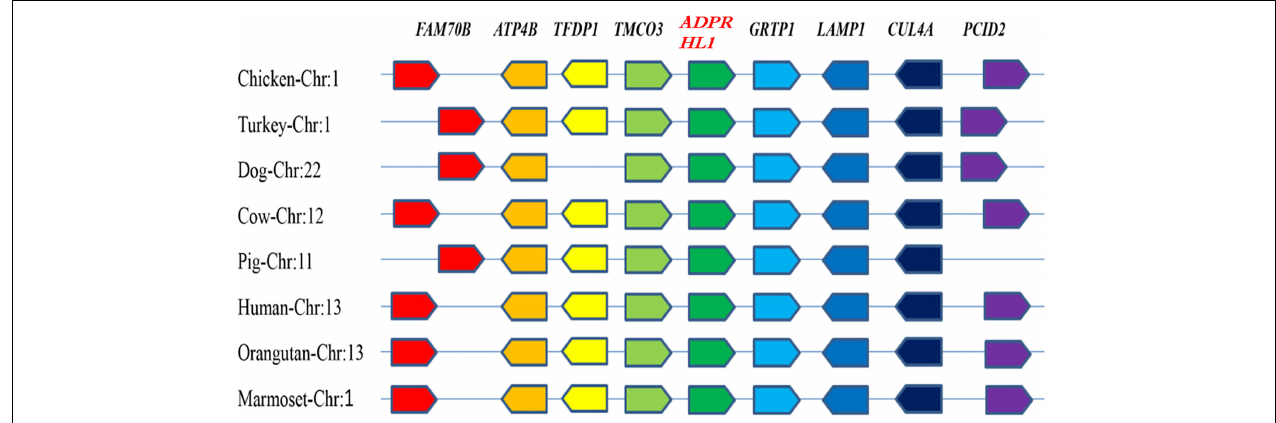
FIGURE 1 | Syntenic analysis of ADPRHL1 genes in different species. Different colors represent different genes.